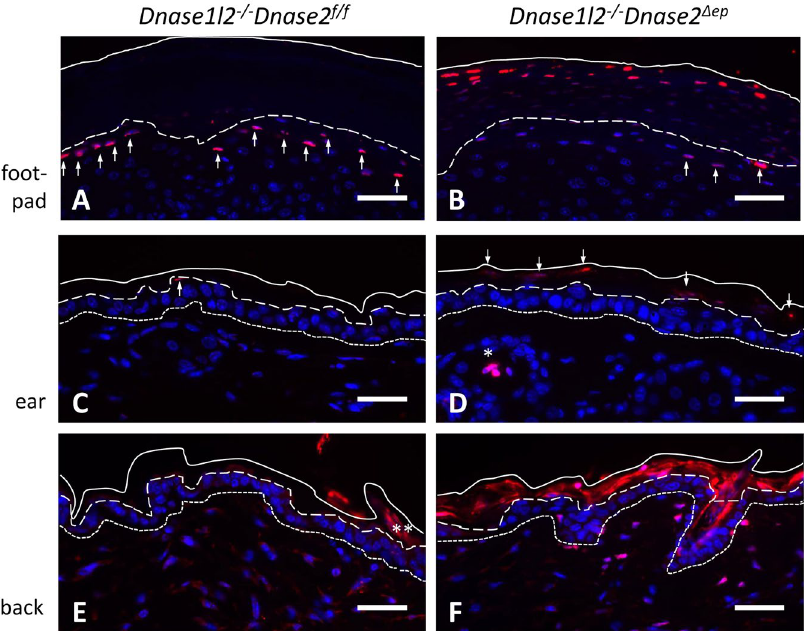
Figure 2. DNA in DNase1L2/DNase2-deficient corneocytes is partially degraded. Thin section of the skin on the footpads ( A , B ), ears ( C , D ), and back ( E , F ) of Dnase1l2 − / − ( A , C , E ) and Dnase1l2 − / − Dnase2 Δ ep ( B , D , F ) mice were subjected to TUNEL labeling and counter-stained with the DNA-specific dye Hoechst 33258. Continuous and dashes lines indicate the outer and the inner border of the stratum corneum, respectively. The basal layer of the epidermis is indicated by dotted lines. The data are representative of at least 3 mice per genotype. Scale bars, 20 µ